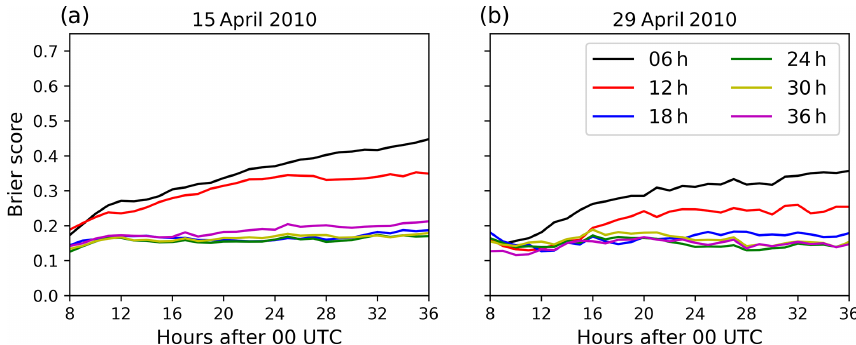
Figure 13. Brier score as calculated by Eq. (10) for each hour and all assimilation window lengths for (a) 15 April and (b) 29 April